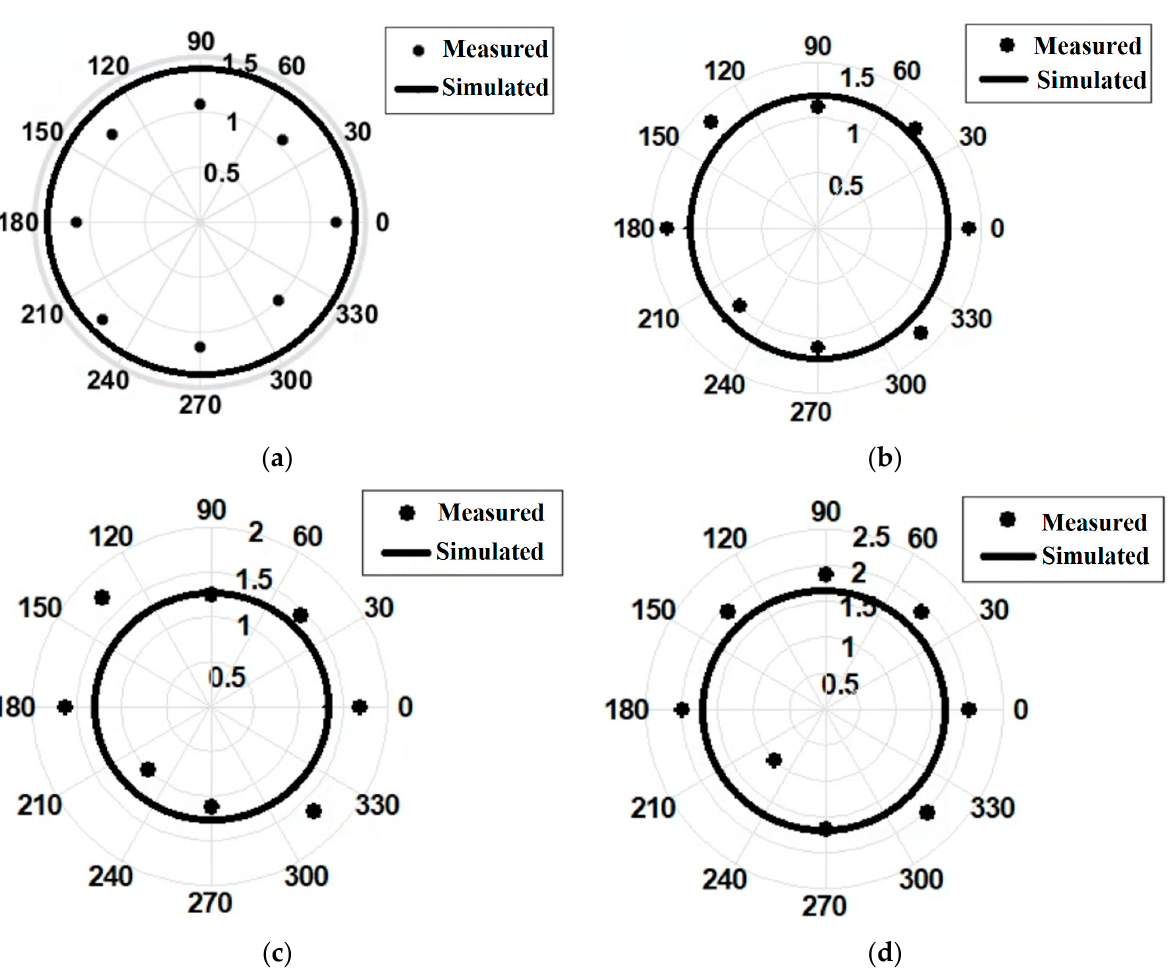
Figure 18. E-plane axial ratio as a function of azimuth angle ( ϕ ) at 12 GHz: versions ( a – d ).